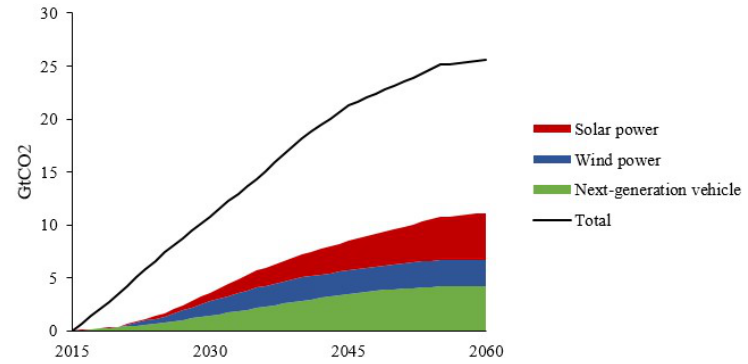
Figure 9. CO 2 emissions reductions by technology in the 2DS relative to RTS. (Data: [4]).